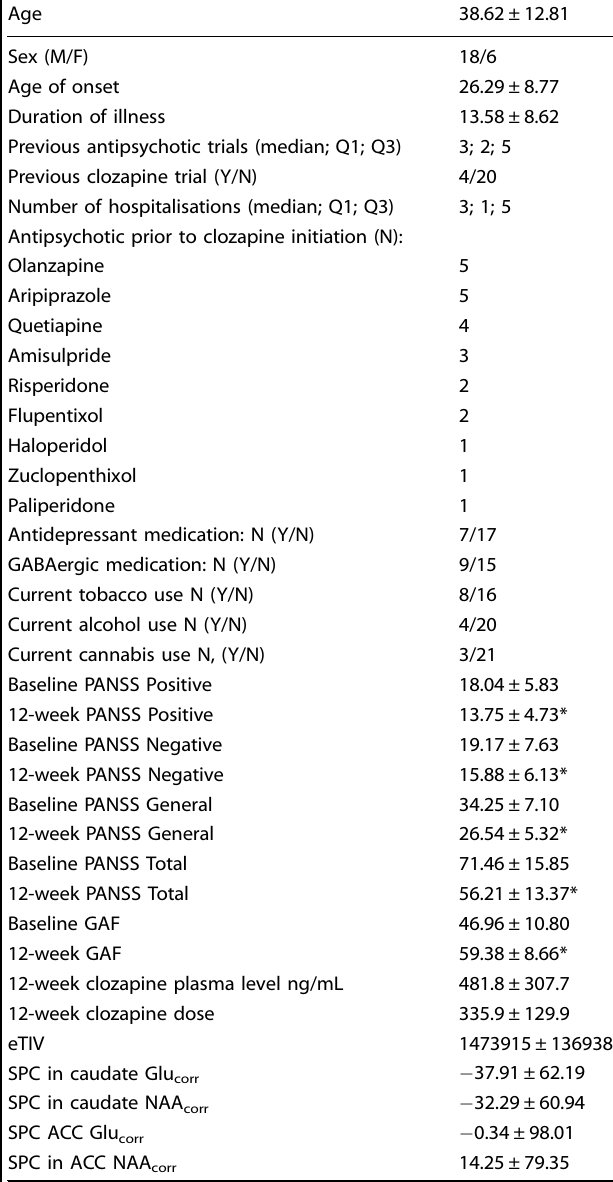
Table 1. Characteristics of the